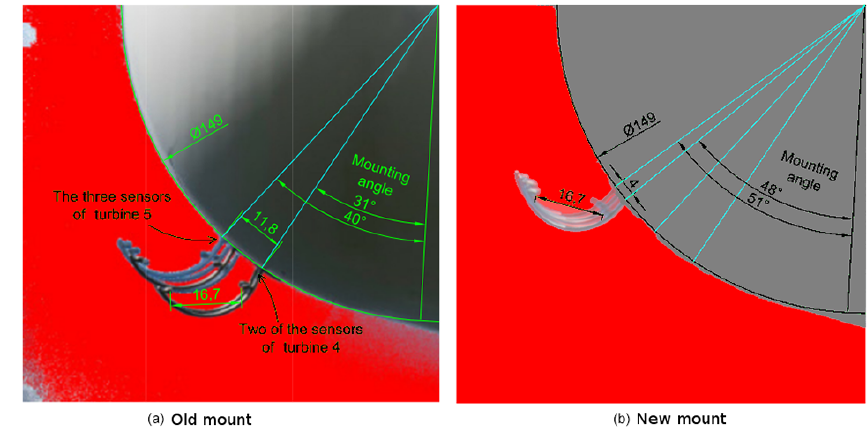
Figure 12. Sonic sensors’ relative mounting position between wind turbine 4 and wind turbine 5 (not to scale; dimensions are in centimeters). Left: original mounting. Right: after improvement of the mounting accuracy. The blue lines connect the center of the spinner sphere with the extreme mounting position of the sensors. In the figure at the right-hand side, four blue lines show the position of the original and improved